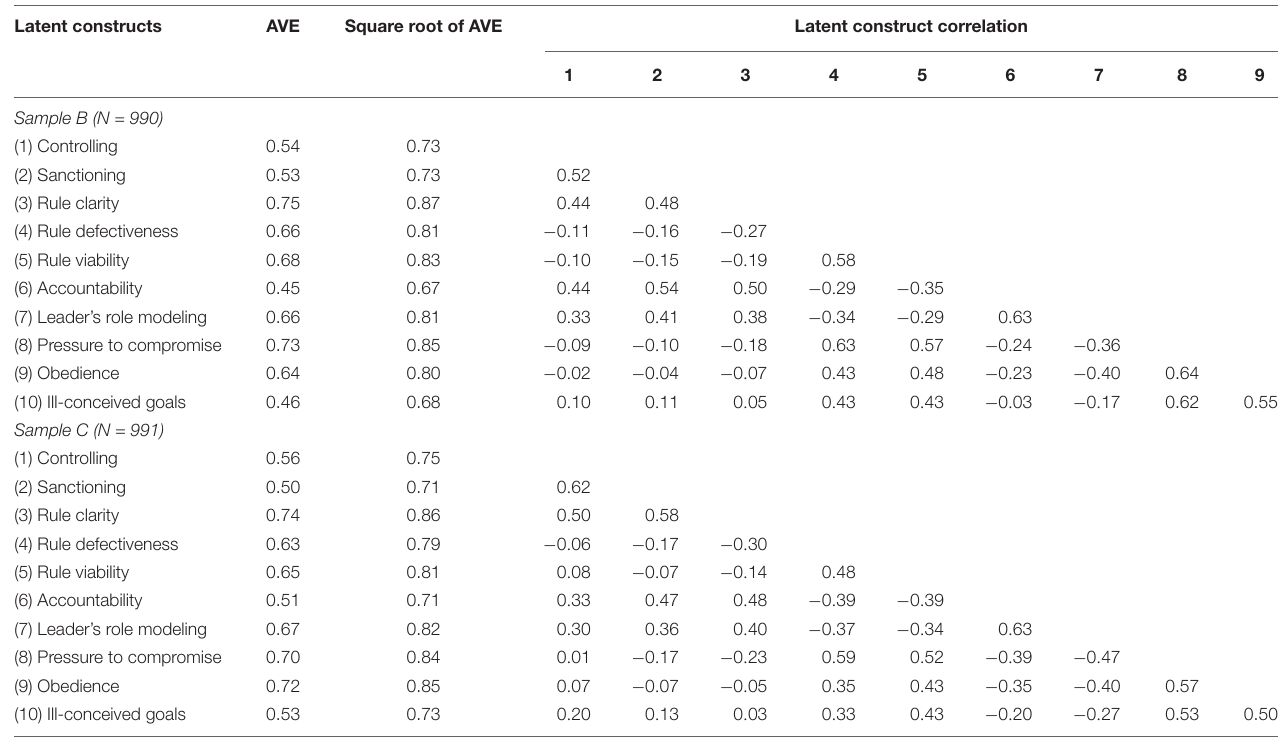
TABLE 5 | Convergent and discriminant validity of the 10-Factor Model (Model C) (Study 1b). Latent